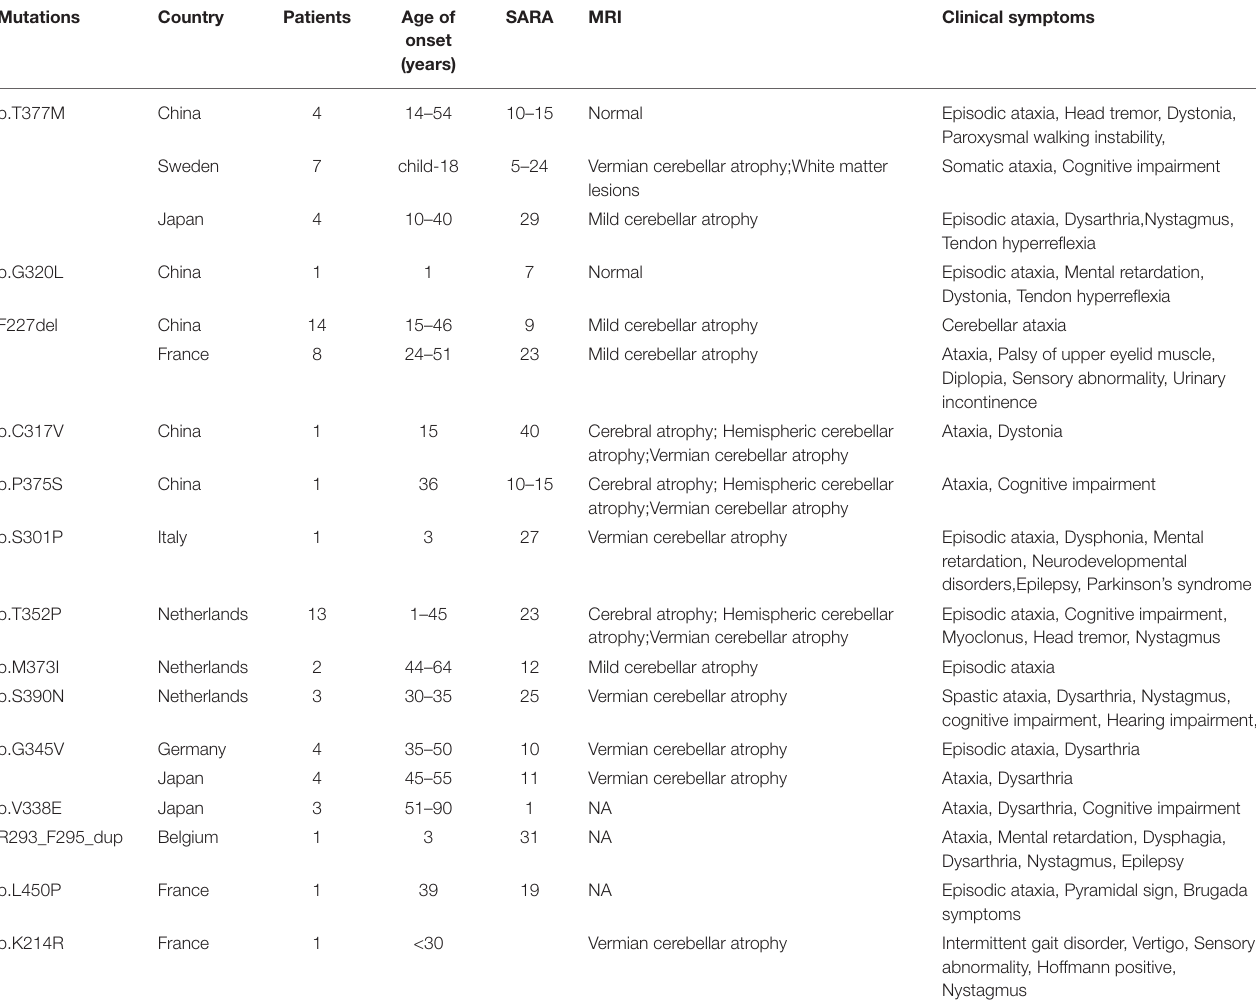
TABLE 3 | Clinical data of KCND3 mutation carriers.